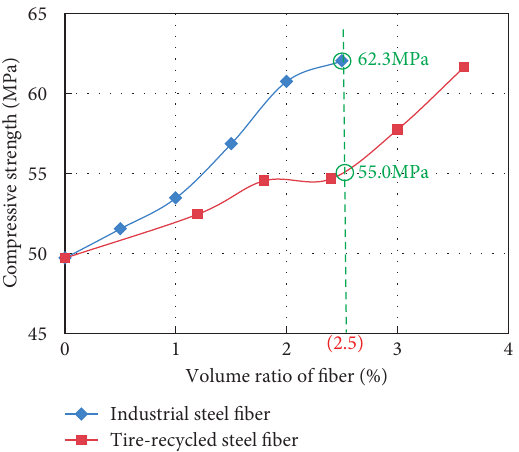
Figure 1: The cubic compressive strength of two types of steel fiber reinforced concrete.